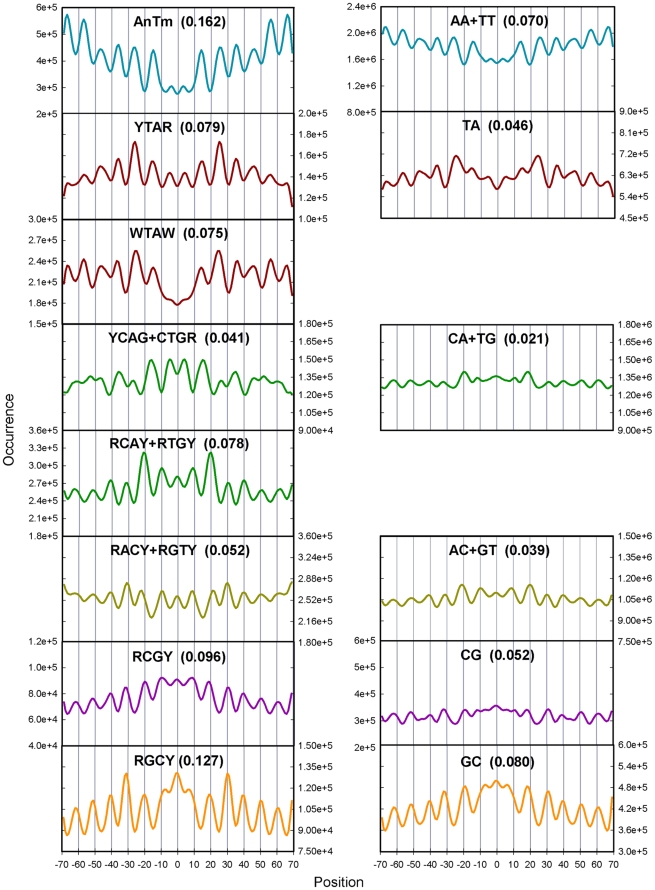
Frequency profiles generated by the tetranucleotide consensus sequences from
Figure 1
.The sums of the occurrences of all tetranucleotides in the Kaplan et al. 2009 in vitro replicate 1 library [12] that make up the consensus sequences from Figure 1 are given in the left panels of the figure. The profiles of the corresponding central dinucleotide sequences of the tetranucleotides are shown in the right panels. The numbers adjacent to the sequence designation in parentheses are the FVO10.2 values.